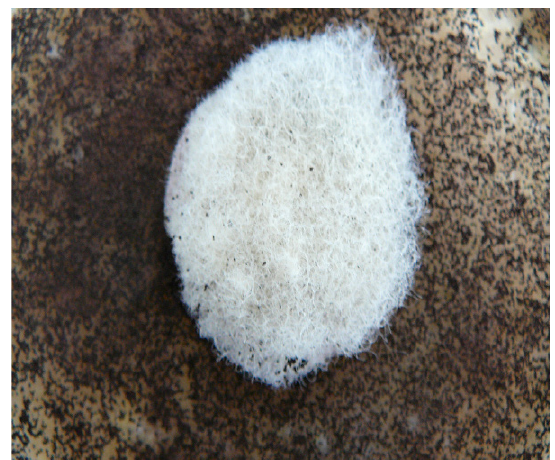
Figure 4. The sheepskin (BP1) treated with AgNPs, after 14 days of fungi exposure.